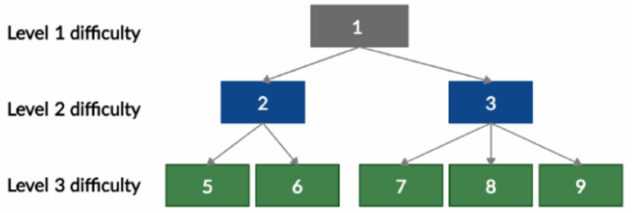
Figure 2. Example of a competence tree